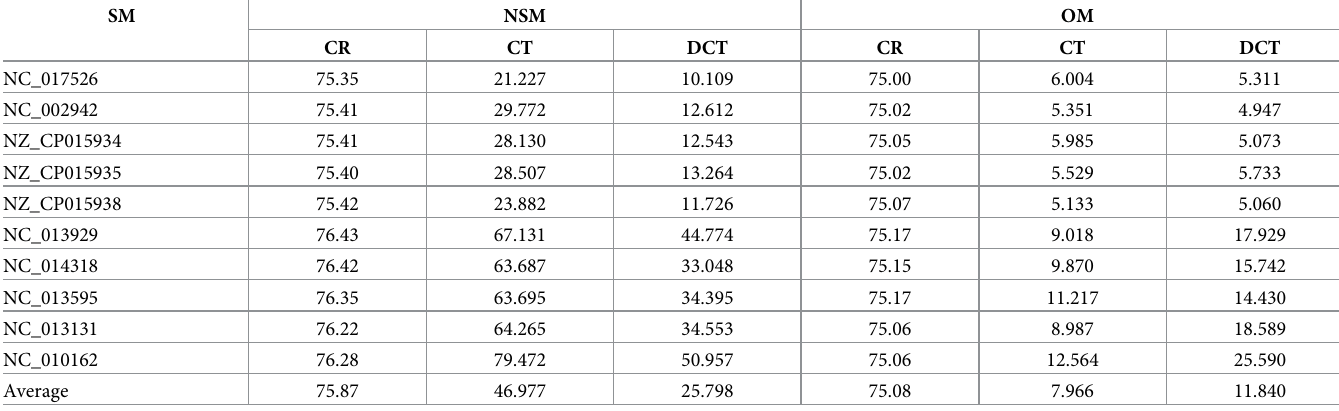
Table 2. The results between our method and